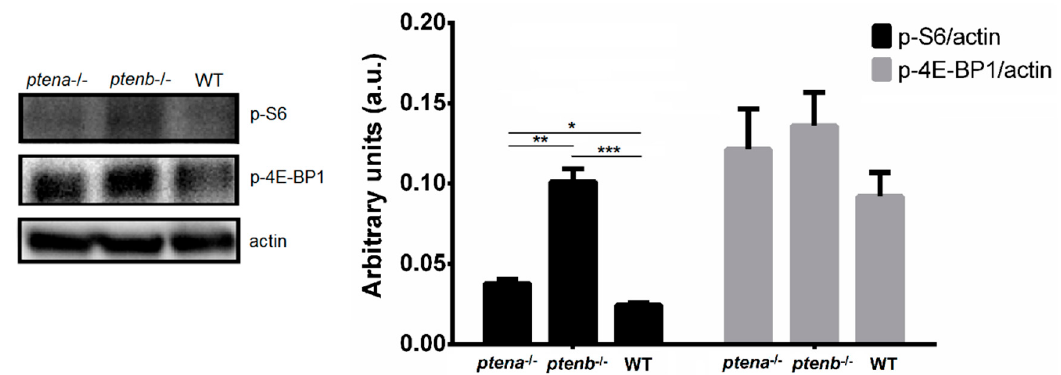
Figure 3. Western blot analysis of the phosphorylation of the mammalian target of rapamycin (mTOR) downstream proteins S6 (p-S6) and 4E-BP1 (p-4E-BP1). The intensity of the bands was normalized to the actin protein level. The graphs represent the means ± SEMs of 5 pools of larvae. Statistically significant differences are displayed as *** (0.0001 < p < 0.001), ** (0.001 < p < 0.01) or * (0.01 < p < 0.05).